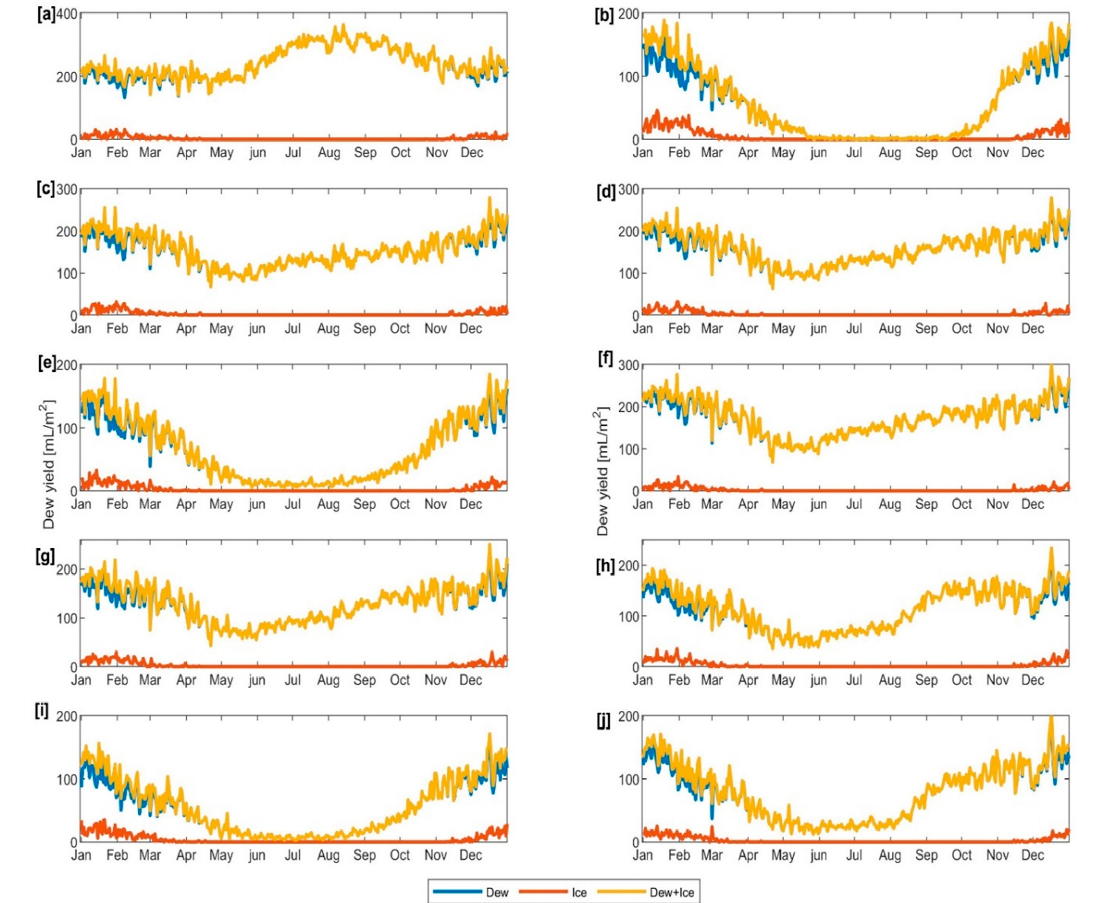
Figure 5. Mean daily cumulative dew yield (blue line), ice (i.e., hoarfrost) (red line) and dew + ice (yellow line) during 1979–2018 at the selected sites: ( a ) Irbid, ( b ) Mafraq, ( c ) Amman, ( d ) Madaba, ( e ) Azraq, ( f ) Dead Sea, ( g ) Karak, ( h ) Petra, ( i ) Ma’an, ( j ) Aqaba. The subplots are in sequential order according to site number from 1 to 10 (Figure 1).